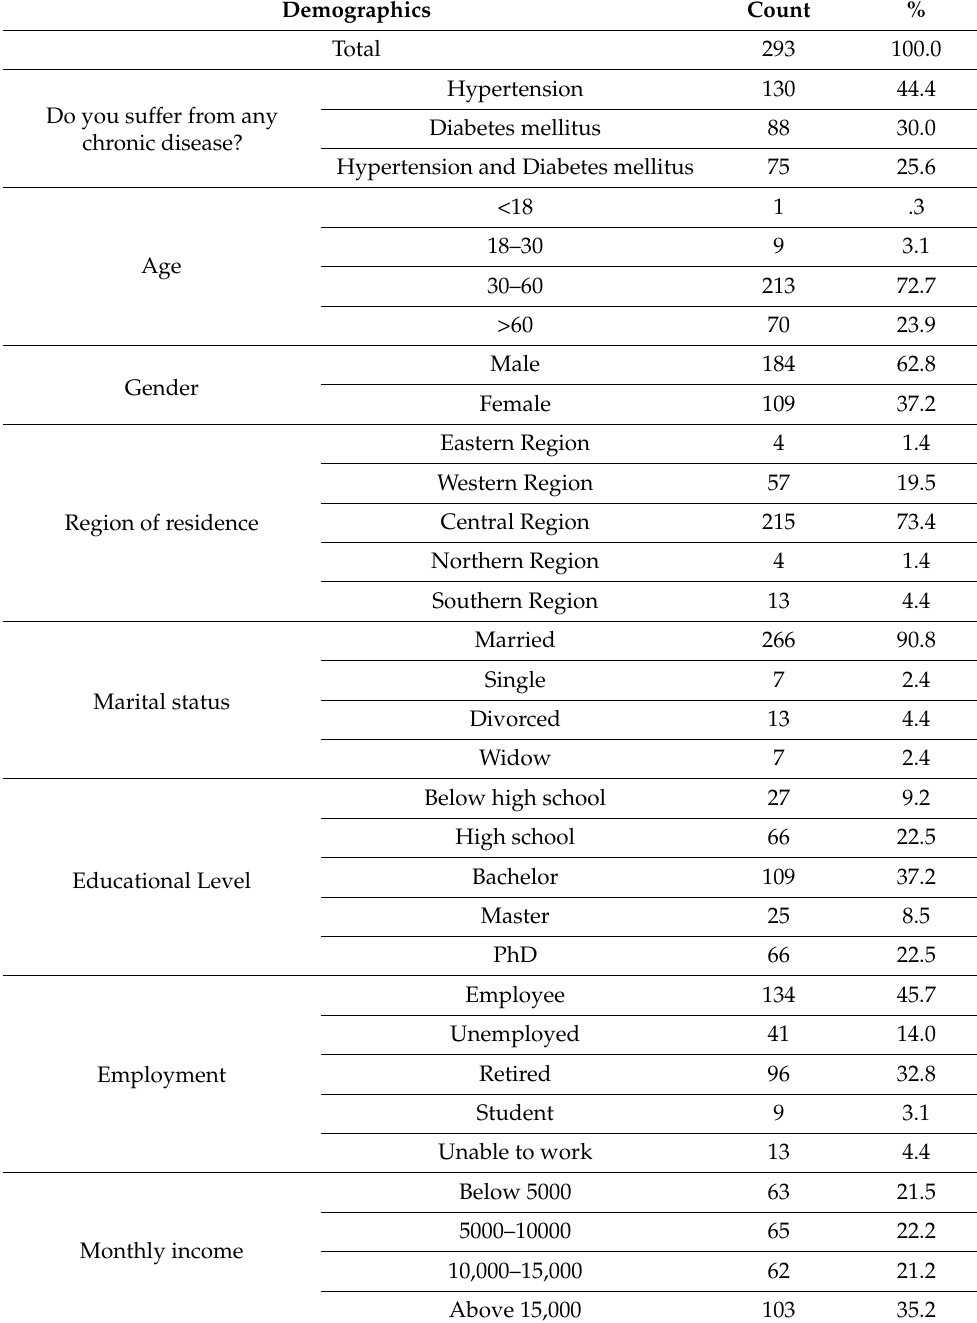
Table 1. Socio-demographic characteristics of the study